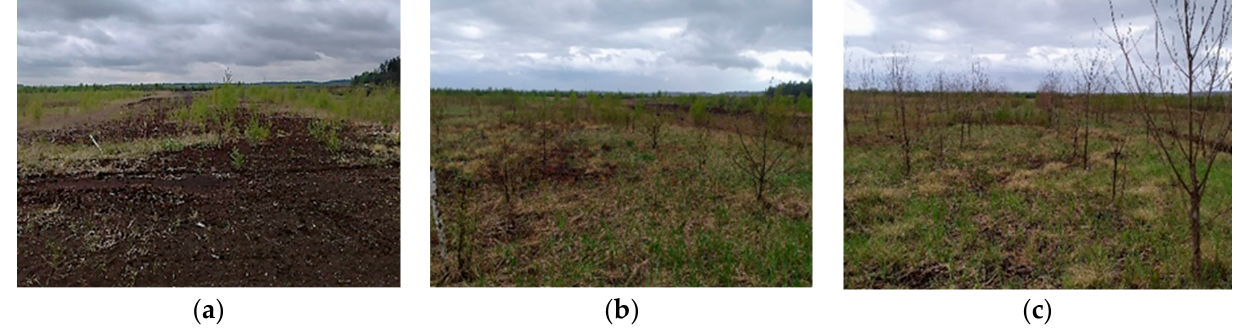
Figure 6. Vegetation cover four years after treatment with wood-ash fertiliser in different doses: ( a ) control group; ( b ) 10 tons per hectare; ( c ) 15 tons per